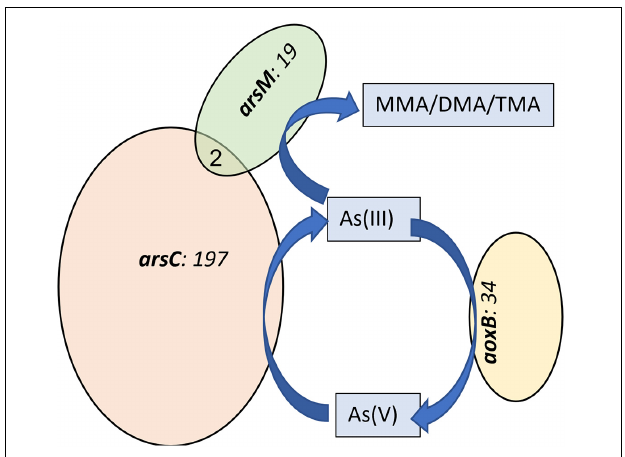
FIGURE 1 | Venn diagram showing the number of unique and shared functional gene probes containing different arsenic transforming gene probes from all treatments. Numbers within the Venn diagrams represents total number of positive gene probes